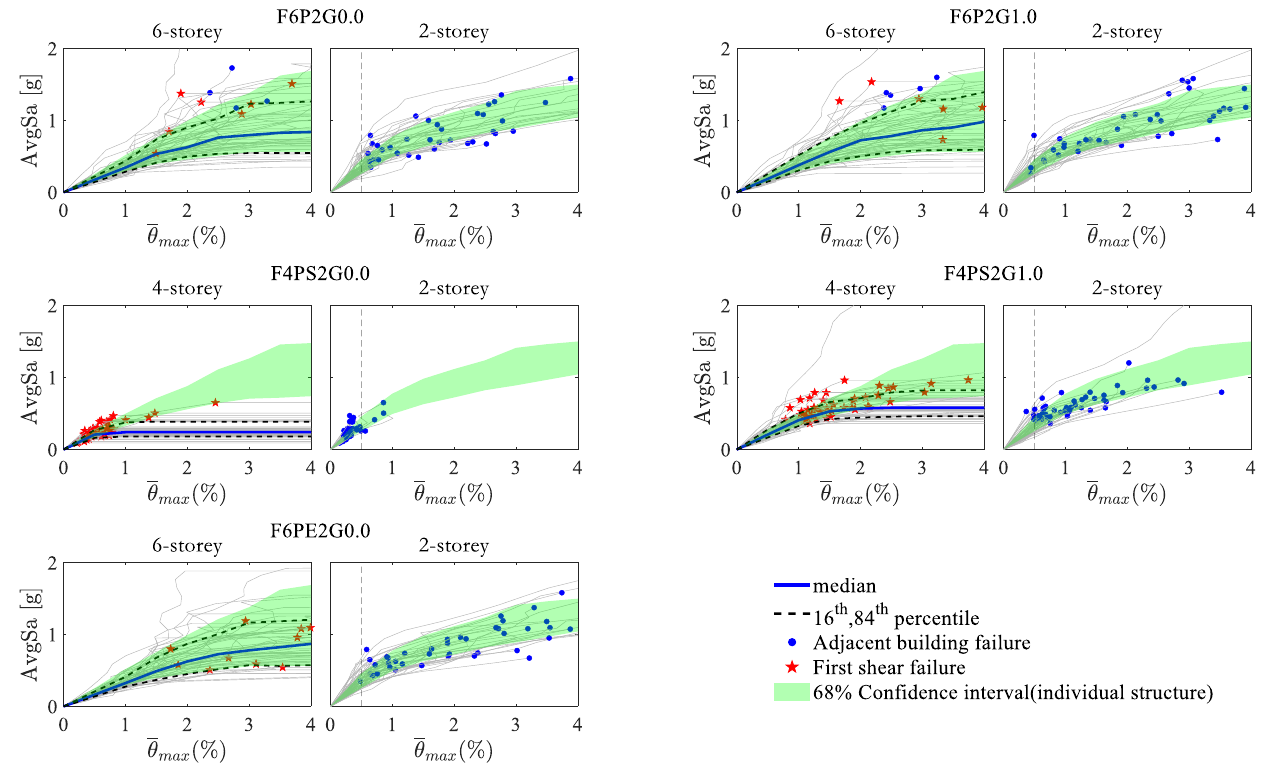
Figure 15. IDA curves obtained for some of the pounding configurations.